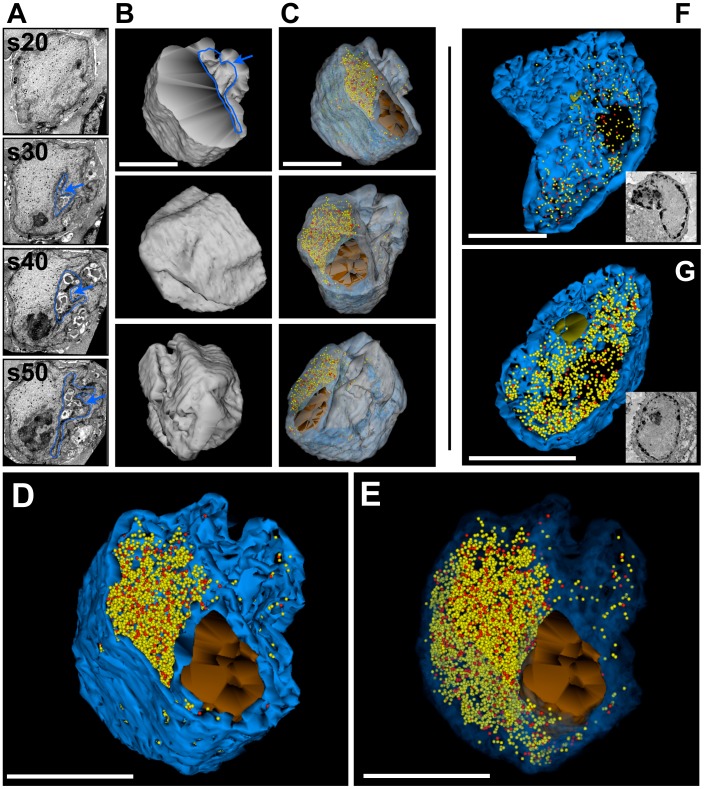
Three-dimensional distribution of VZV nucleocapsids in cell nuclei without PML cages.Melanoma cells were infected with VZV for 48 h and processed for SSA-SEM (A–E) or serial section TEM (F and G). A) BSE-SEM images of four representative sections (s20, s30, s40, s50) from a series of 50 consecutive 100 nm sections are shown. A nuclear indentation is outlined and marked with a blue arrow. See also Video S1. (B) 3D model of the shape of the VZV infected nucleus (grey). Upper panel (front view): the cross section plane and a deep invagination (blue arrow) of the nucleus are visible. The middle panel (side view) and bottom panel (rear view) reveal the irregular shape of the nucleus with numerous indentations. (C) View of the same nucleus at different angles in transparent mode. Color code: transparent grey, boundary of the nucleus; transparent blue, electron dense heterochromatin; brown, nucleolus; red spheres (mature capsids, C-type) and yellow spheres (immature capsids, A and B-type). A total of 4,223 capsids were identified and visualized. (D) Higher magnification view; color code as in C, but nuclear envelope not shown. The dense heterochromatin (solid dark blue) hides nucleocapsids that are located deeper in the nuclear volume. (E) Same view as in D, but with transparent heterochromatin: the distribution of capsids throughout the nucleus is revealed. See also Video S2. (F and G) Two different nuclei that were reconstructed from serial sections imaged by TEM. The color code is the same as above. Insets show representative images from the TEM series. The 3D models show the distribution of 425 (F) and 1,340 capsids (G), respectively. See also Video S3. All scale bars are 5 µm.